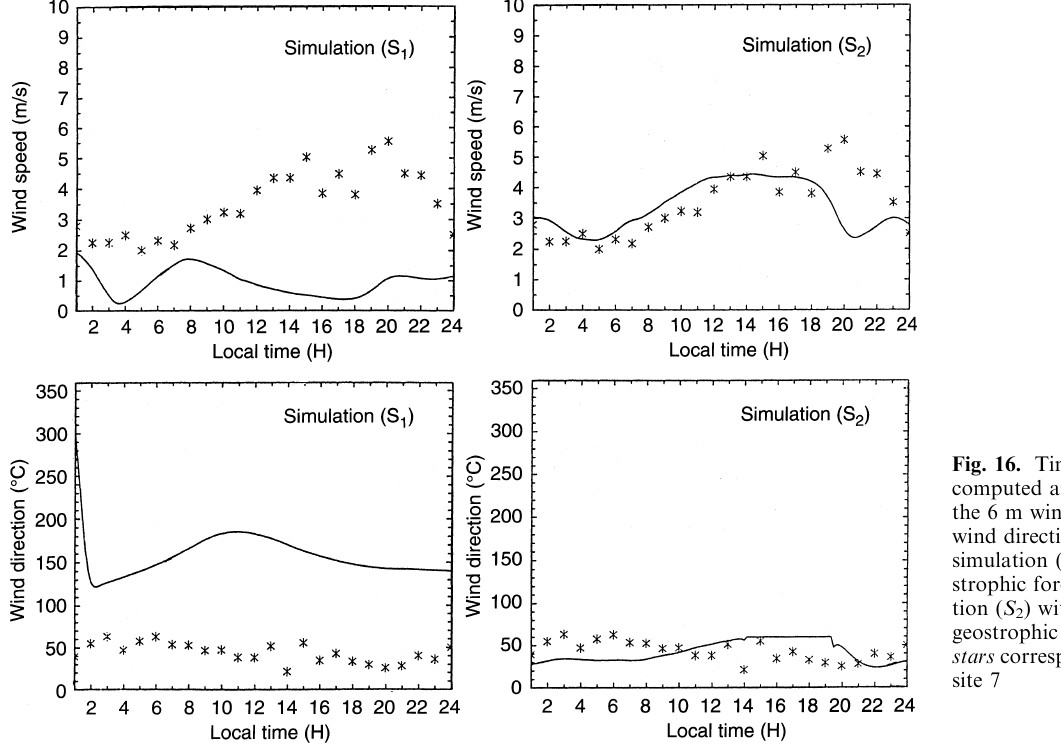
Fig. 16. Time evolution of the computed and measured values of the 6 m wind speed and the 6 m wind direction, resulting from the simulation ( S ) without geo- 1 strophic forcing, and the simula- tion ( S ) with a specific easterly 2 geostrophic wind of 2 ms ) 1 . The stars correspond to observations at